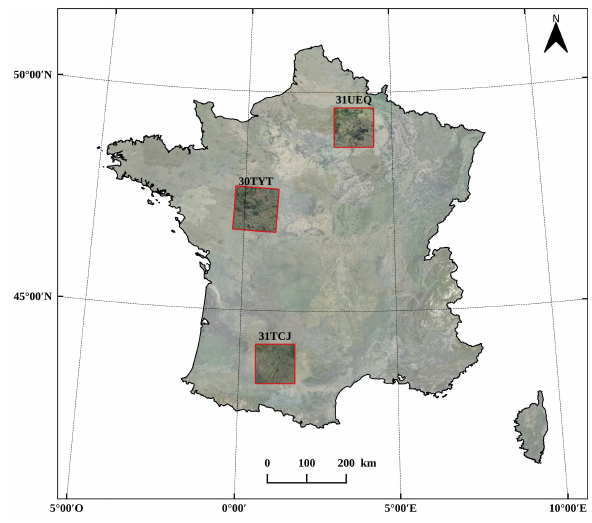
Figure 1. Overview of the three study sites represented by three Sentinel-2 tiles: 31UEQ, 30TYT and 31TCJ.